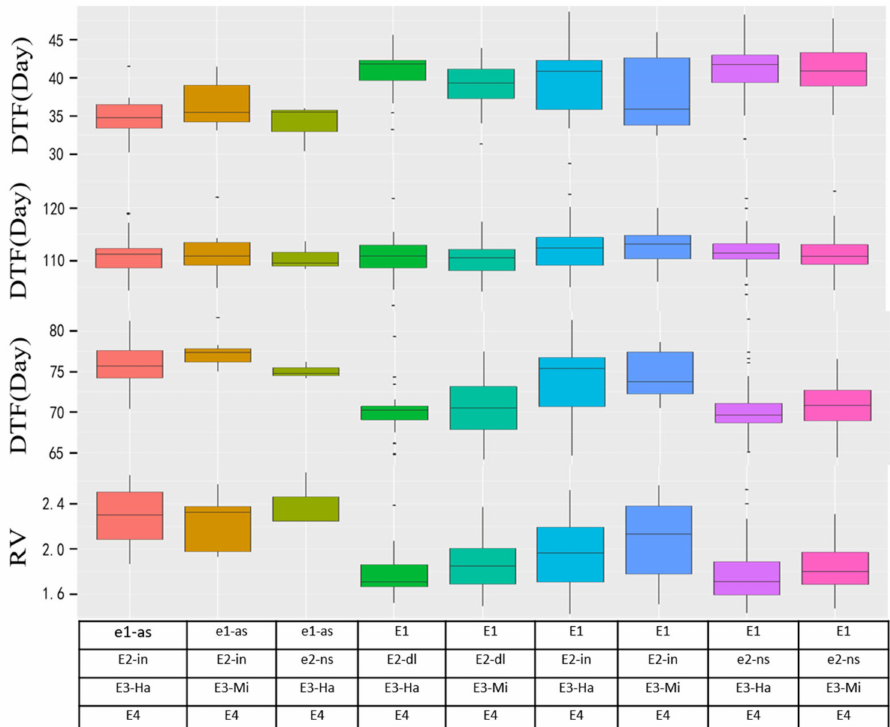
Figure 3. DTF, DTM, RP and R/V of 9 different E genotypes. DTF, days from emergence (VE) to beginning bloom (R1); DTM, days from emergence (VE) to maturity (R8); RP, days from beginning bloom (R1) to maturity (R8); R/V, the ratio of the reproductive period to the vegetative